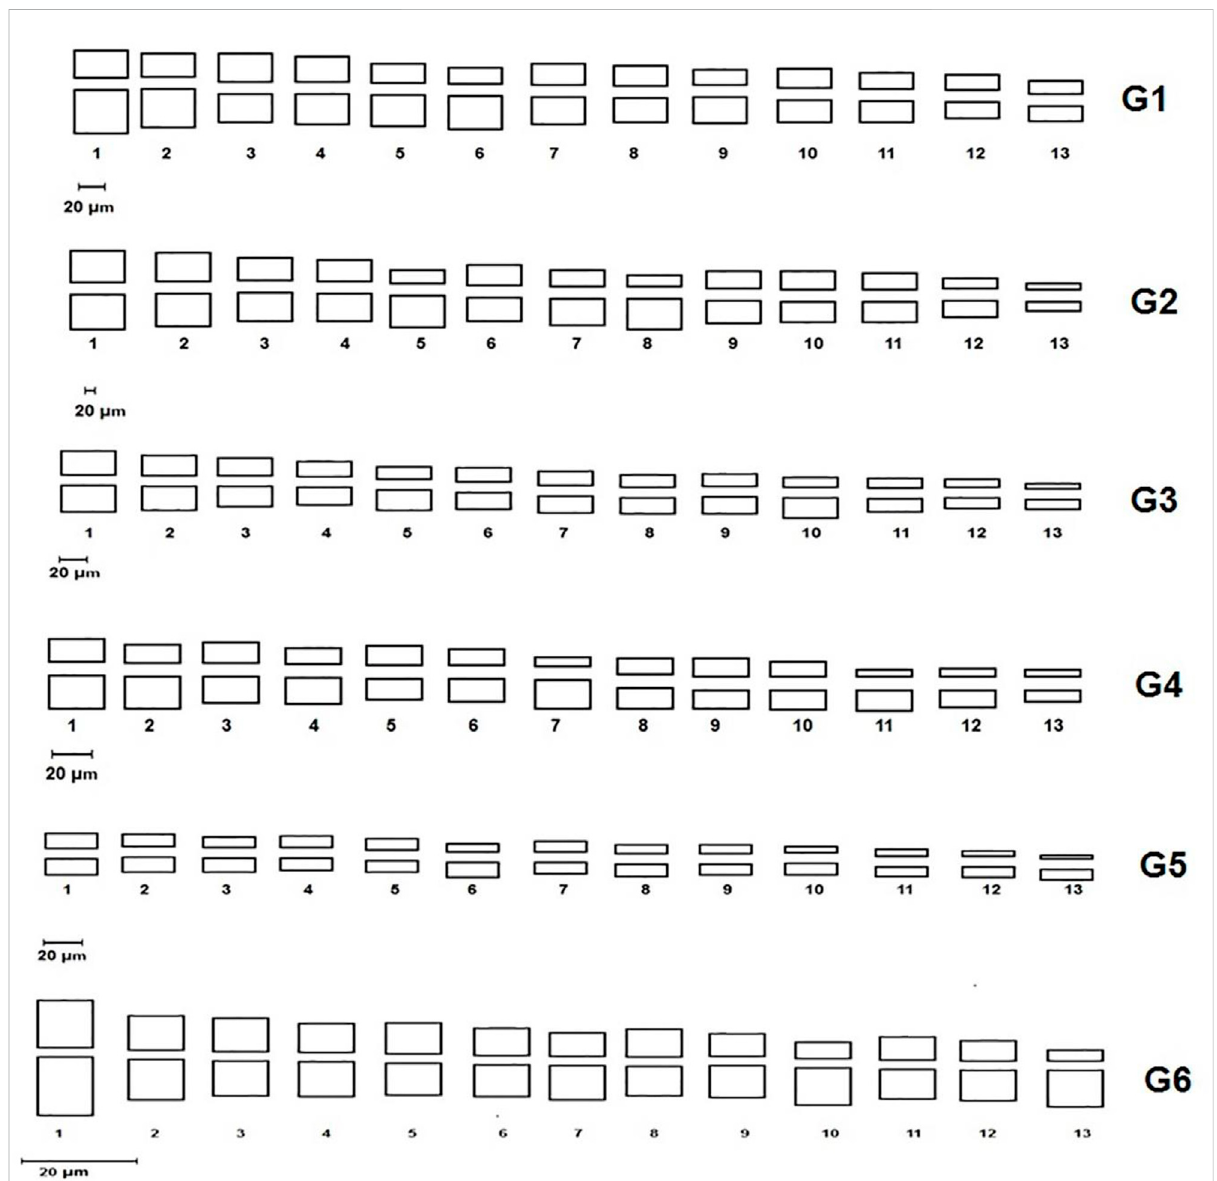
FIGURE 7 IdeogramforhaploidchromosomenumberofthestudiedSesamegenotypes.(G1)Ahs-670,(G2)As-1236,(G3)Bah-697,(G4)Jiz-511,(G5)Jiz- 517 and (G6)